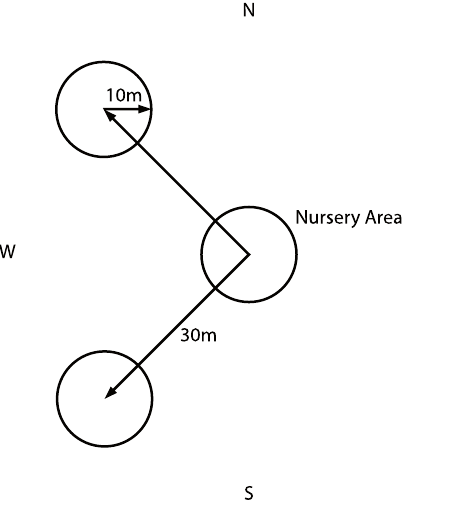
Fig. 2. Schematic of the three 10 m-radius sampling plots used to collect detailed vegetation data and other site characteristics at caribou nursery sites and randomly chosen absence sites on lakes in Wabakimi and Woodland Caribou Provincial Parks, northern Ontario.